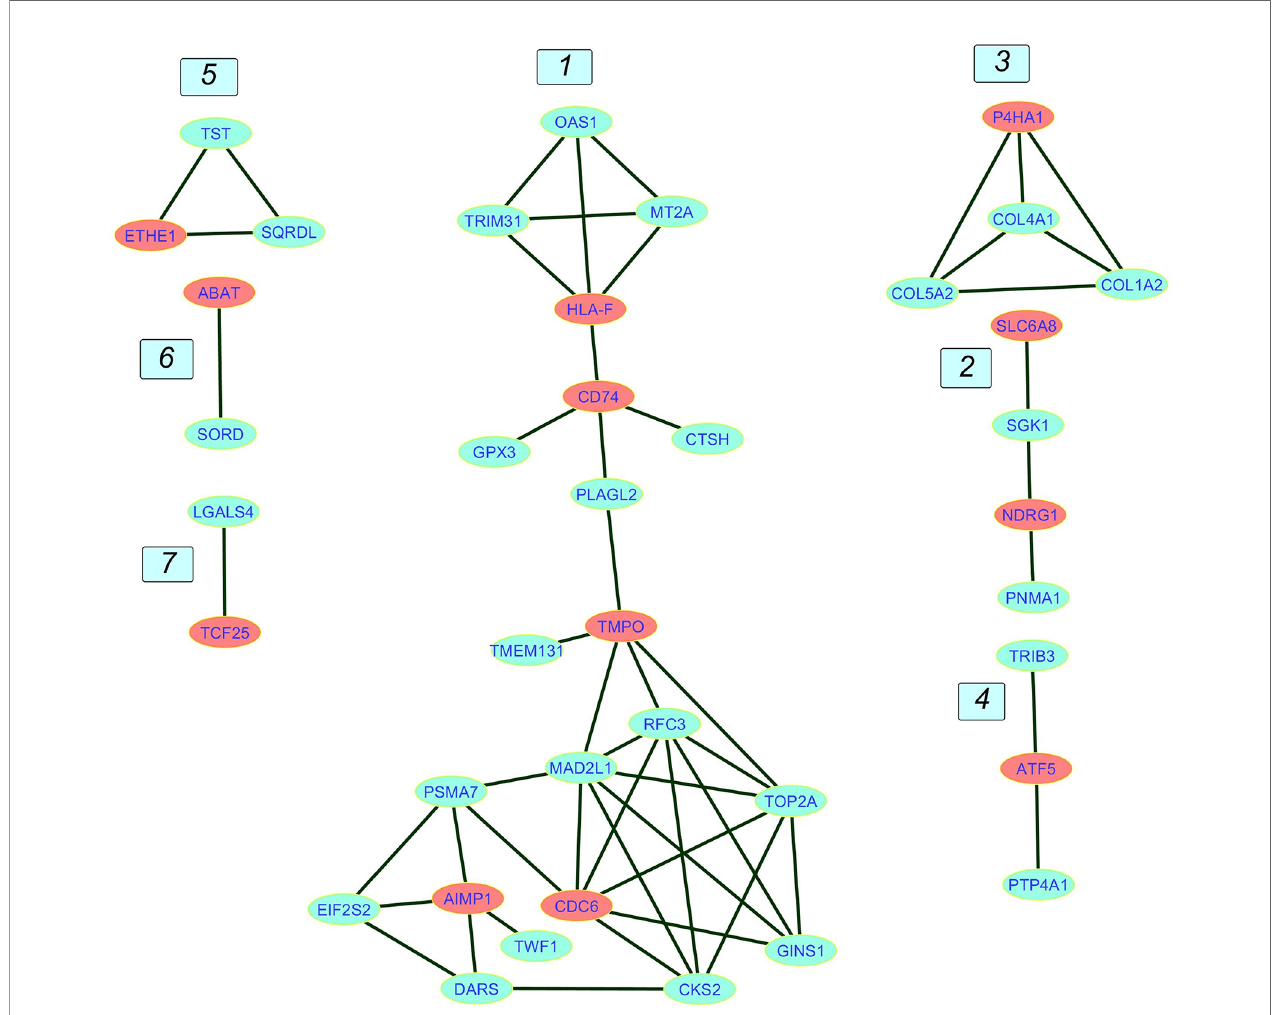
FIGURE 4 | The Core network. The network contains seven components numbered from 1 to 7. Component 1 is the giant component. Core genes are in red and non-core genes are in